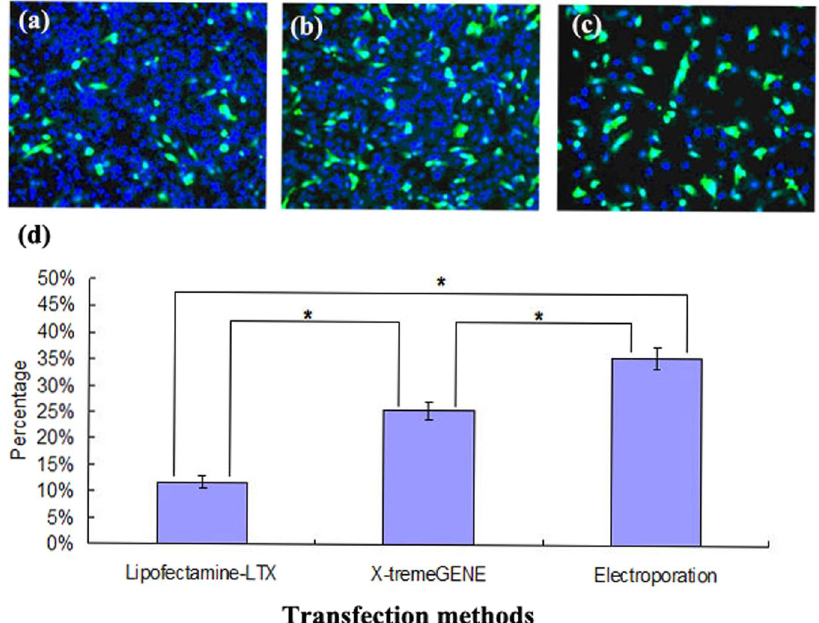
Figure 1. BFFs transfected with pEGFP-N1 by means of lipofectamine-LTX ( a ), X-tremeGENE ( b ), electroporation ( c ) and their percentage expressing EGFP ( d ). Nuclei were stained with Hoechst33342. Data are from three replicates (n = 3), presented as mean ± SEM and analyzed by one-way ANOVA ( * P <